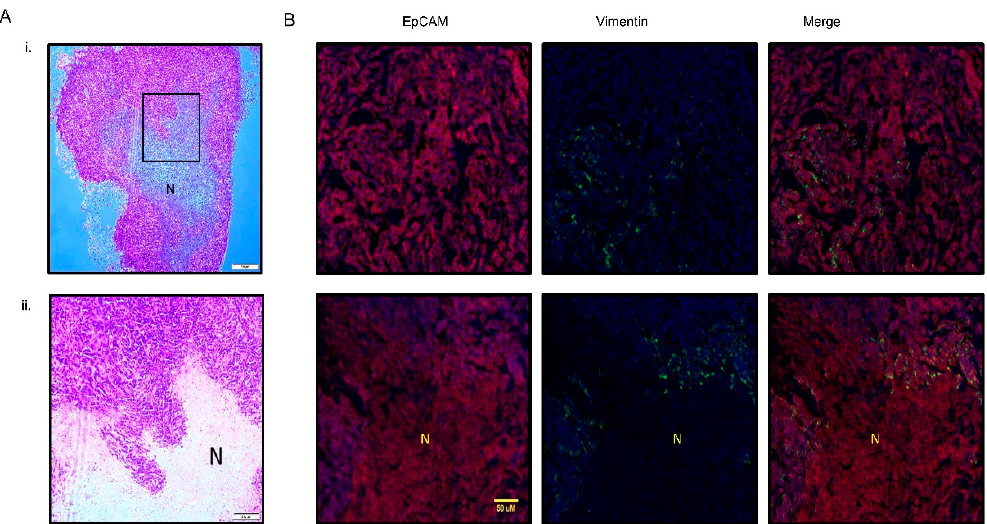
Figure 4. ( A ) Hematoxylin and eosin staining of xenograft PMC42-LA tumor; ( i ) low magnification